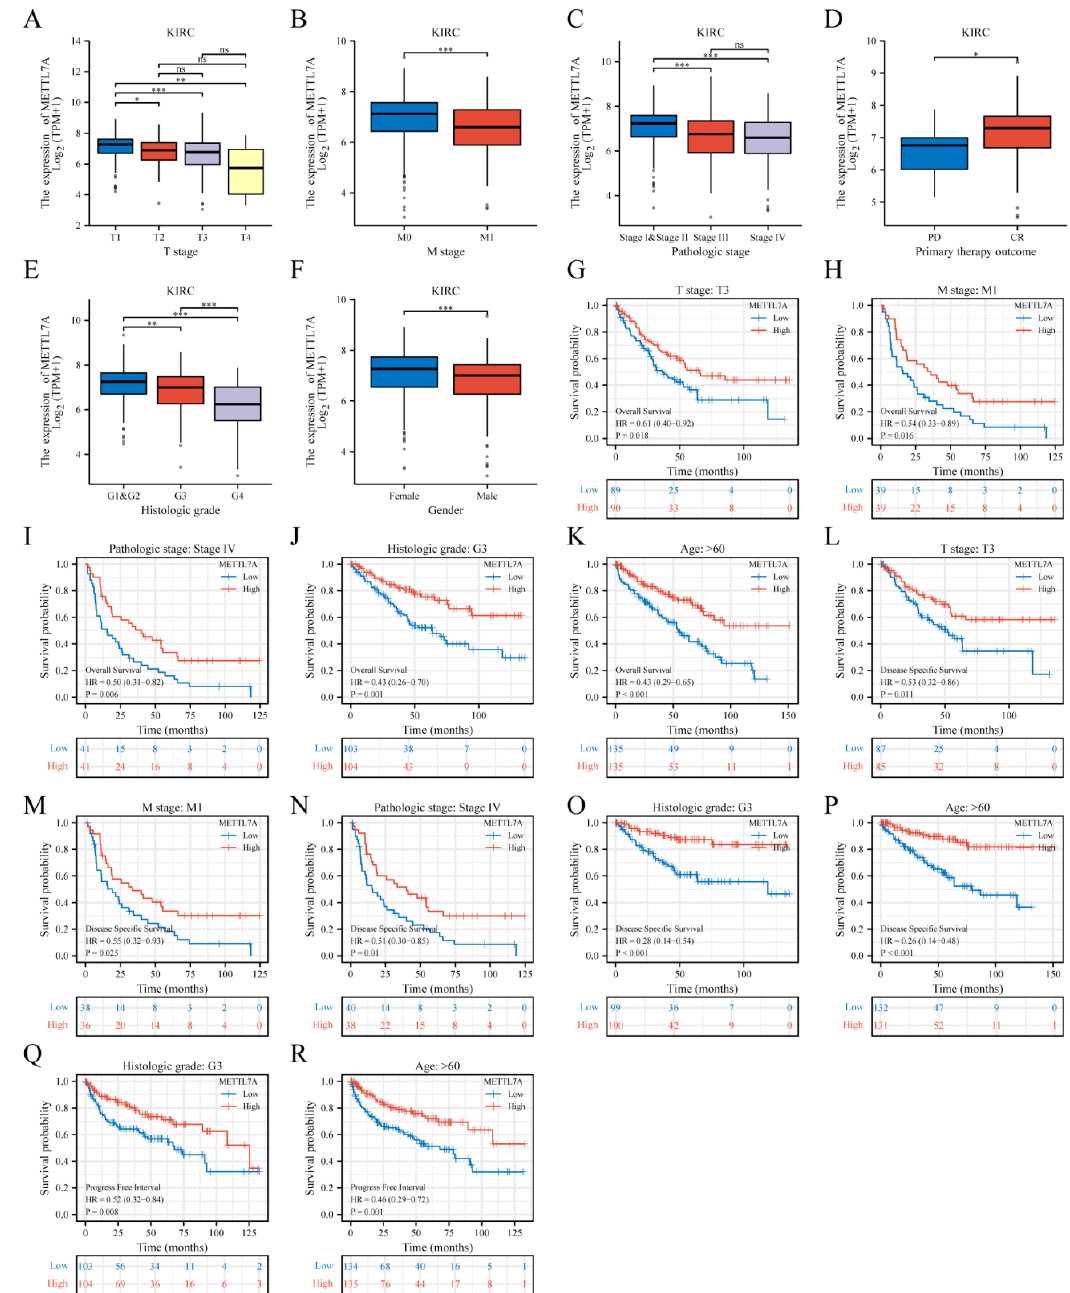
Figure 6. METTL7A expression and prognostic value analysis in various clinical subgroups of KIRC.